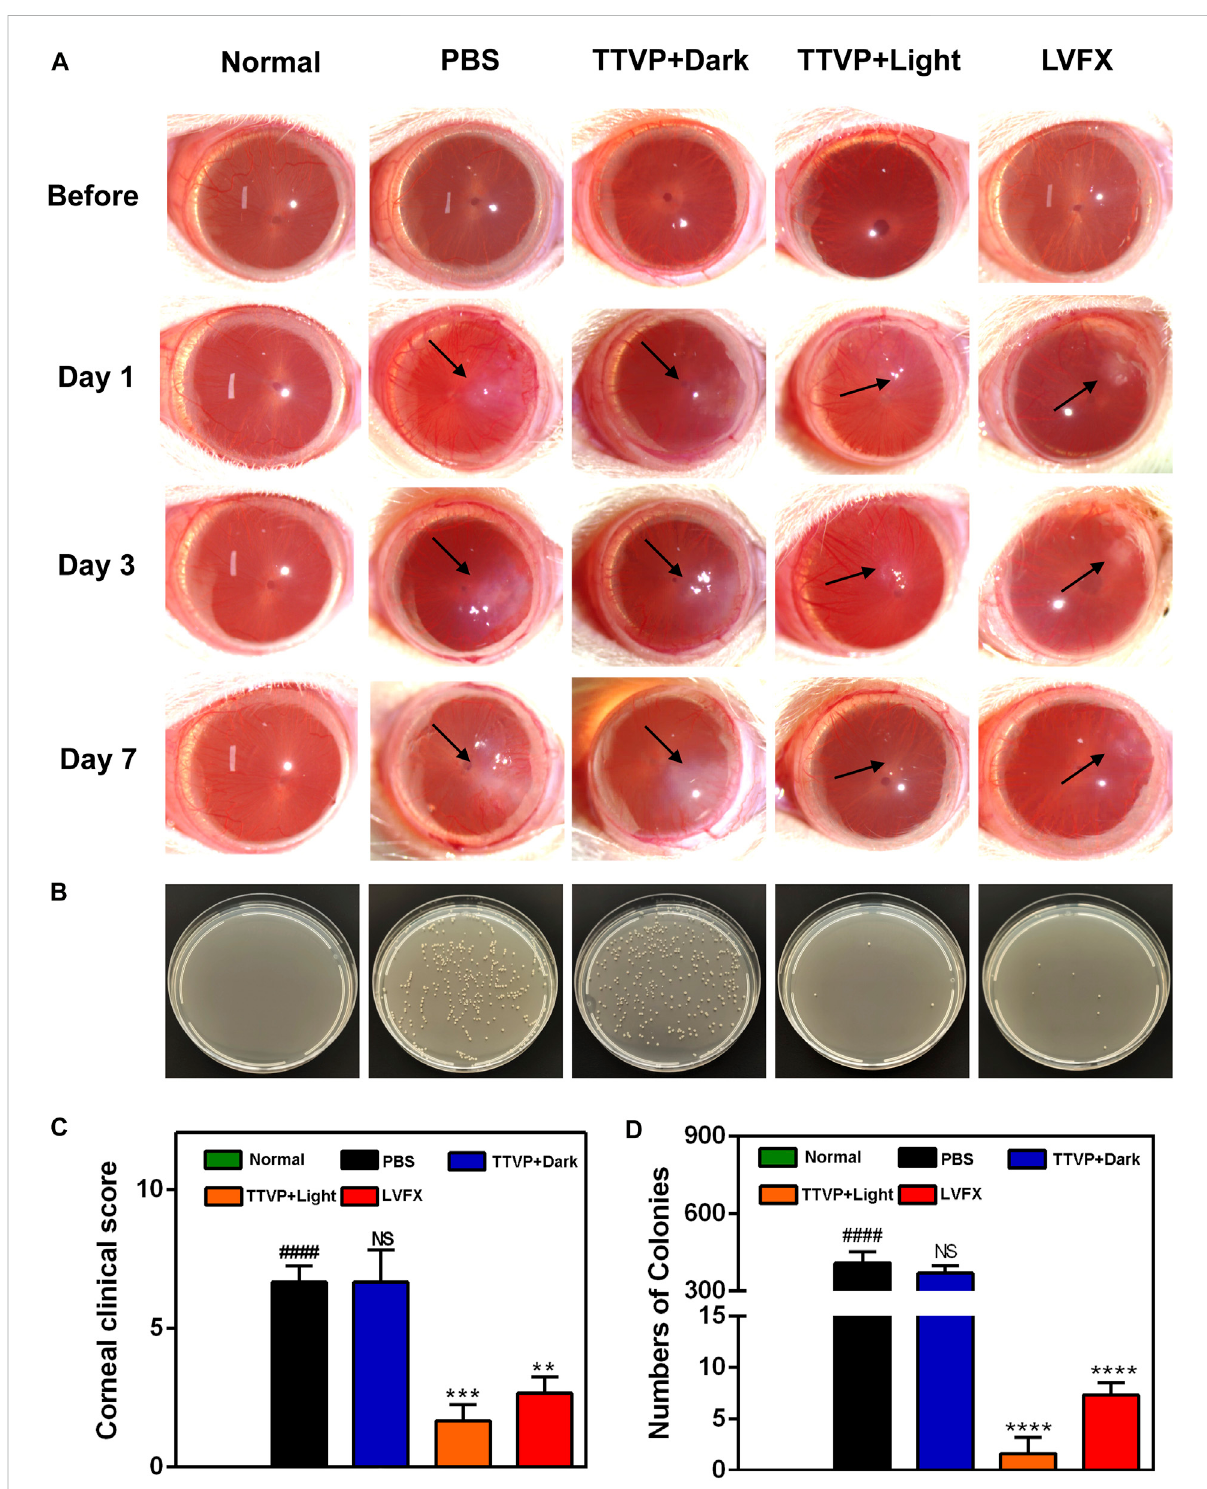
FIGURE 4 (A) Representative photographs of rat eyes before and at 1, 3 and 7 days after treatment. (B) The bacterial cultures on agar plates from the corresponding cornea. (C) Clinical score of rat eyes after different treatments; (D) the number of surviving S. aureus in corneas after different treatmentsat7days.#forgroupPBS versus groupNormal,*forgroupTTVP+Dark,TTVP+Light,LVFX versus groupPBS,* p or # p < 0.05,** p or ## p < 0.01, *** p or ### p < 0.001, **** p or #### p < 0.0001, and NS for not signi fi